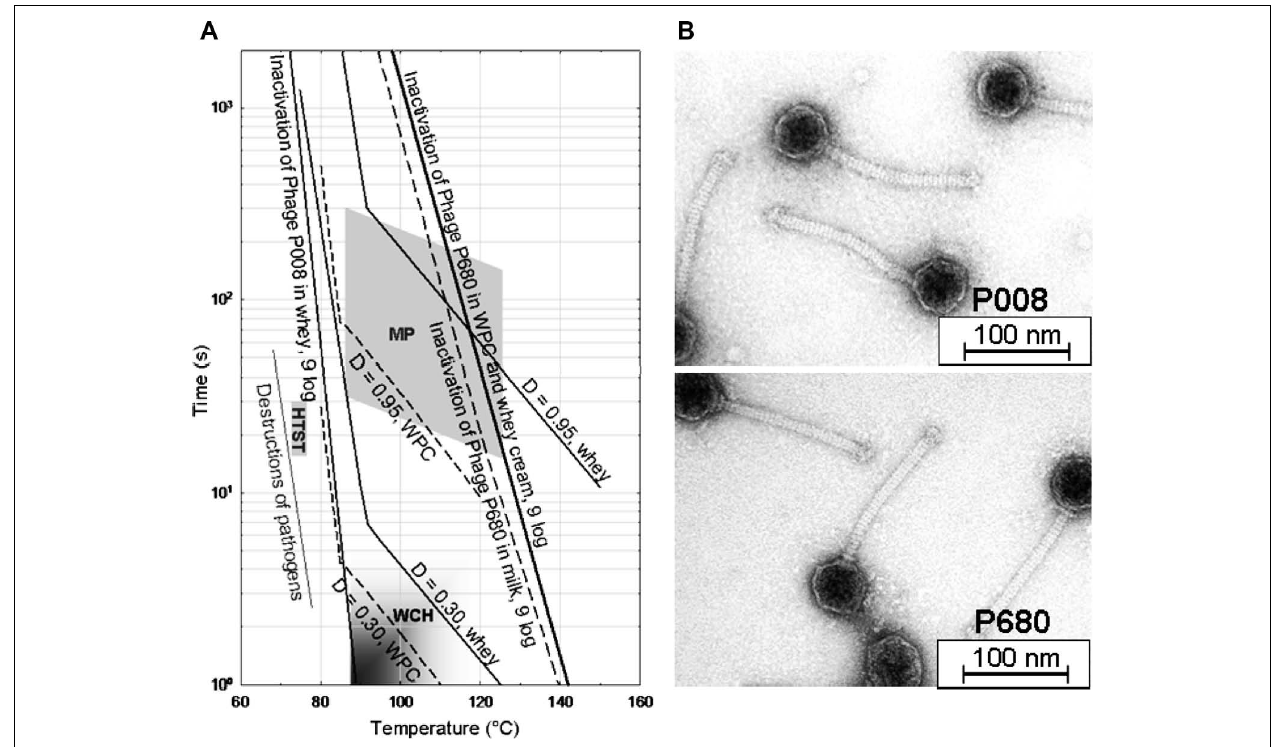
FIGURE 1 |Temperature–time graph of heat treatment of whey protein concentrate (5.3% protein) and skim milk requiredfor 9-log inactivation of Lactococcus lactis phages P680 (heat-resistant) and P008 (heat-sensitive) (A). MP, microparticulation process of whey proteins;WCH,